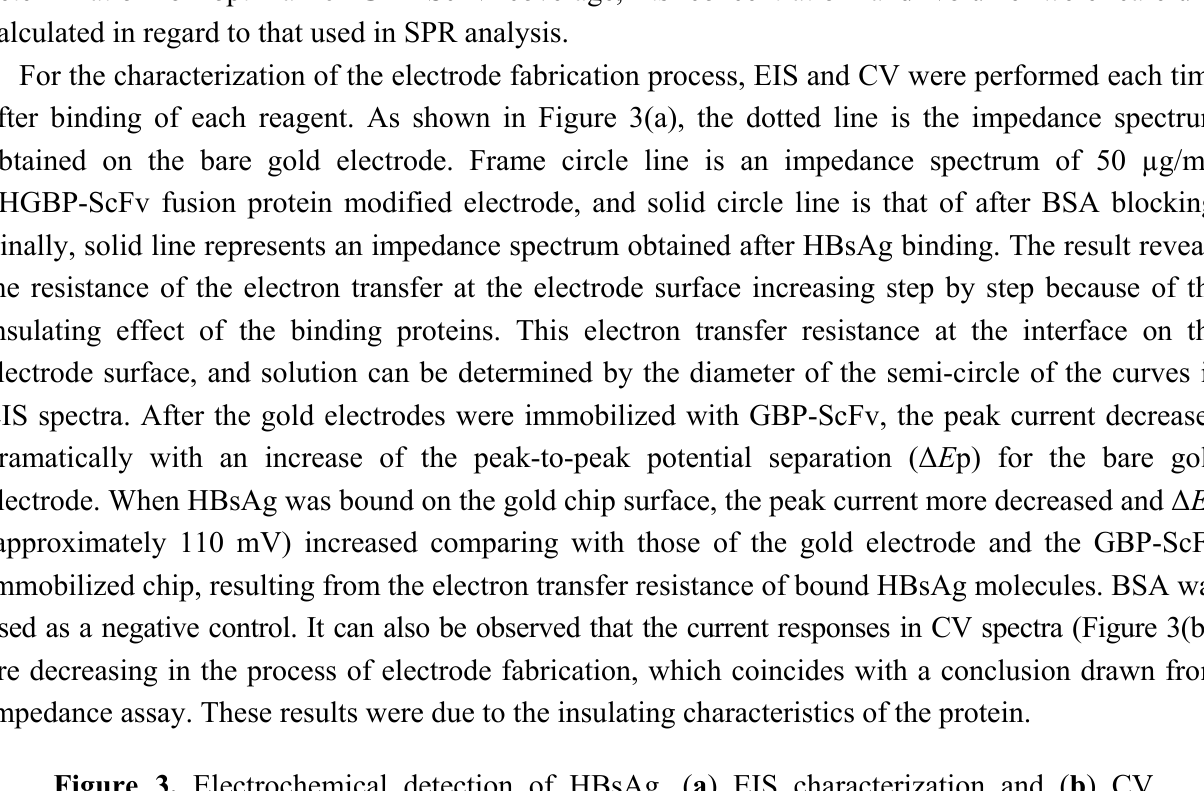
Figure 3. Electrochemical detection of HBsAg. ( a ) EIS characterization and ( b ) CV analysis of the gold electrode fabrication process for the sequential binding of the samples. Dotted line, bare gold; Frame diamond, after 50 μ g/mL 6HGBP-ScFv binding; Solid circle, after 0.5 mg/mL BSA binding; Solid line, after 50 μ g/mL HBsAg